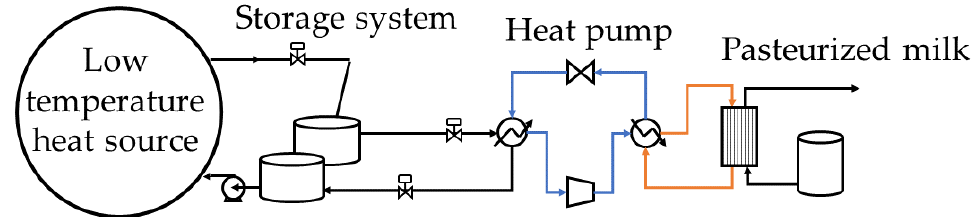
Figure 3. Energy system proposed: low-temperature heat source joined to hot water storage system and joined to a heat pump.